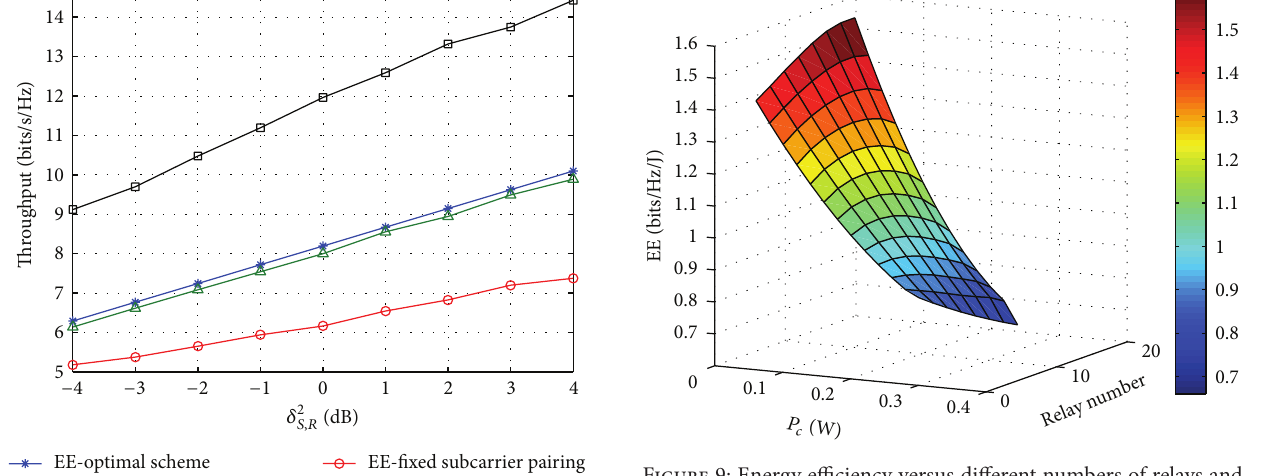
Figure 9: Energy efficiency versus different numbers of relays and circuit energy consumption with 𝑤 1 = 𝑤 2 = 1